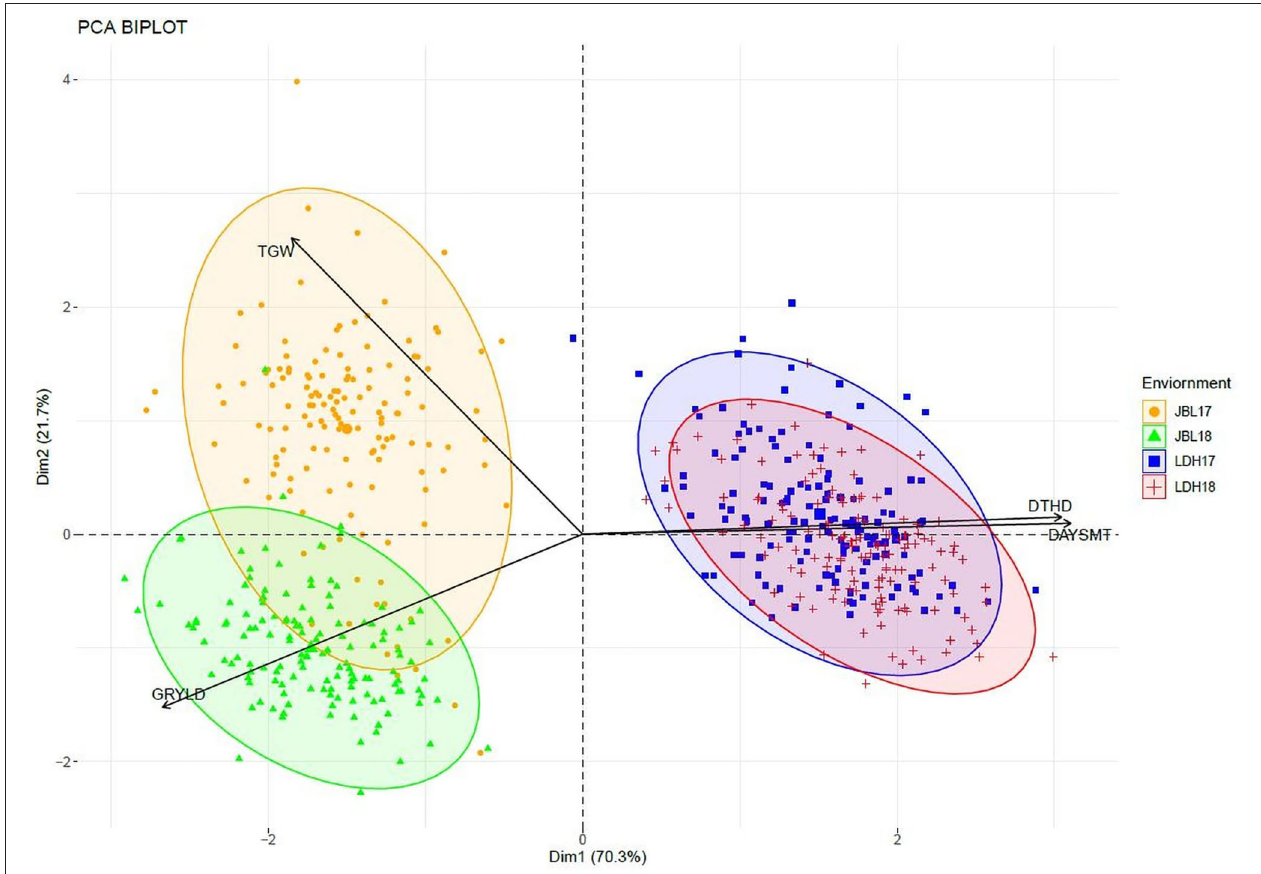
FIGURE 2 | The principal component analysis shows the correlation among GRYLD, TGW, DAYSMT, and DTHD in four environments (LDH17, LDH18, JBL17, and JBL18).